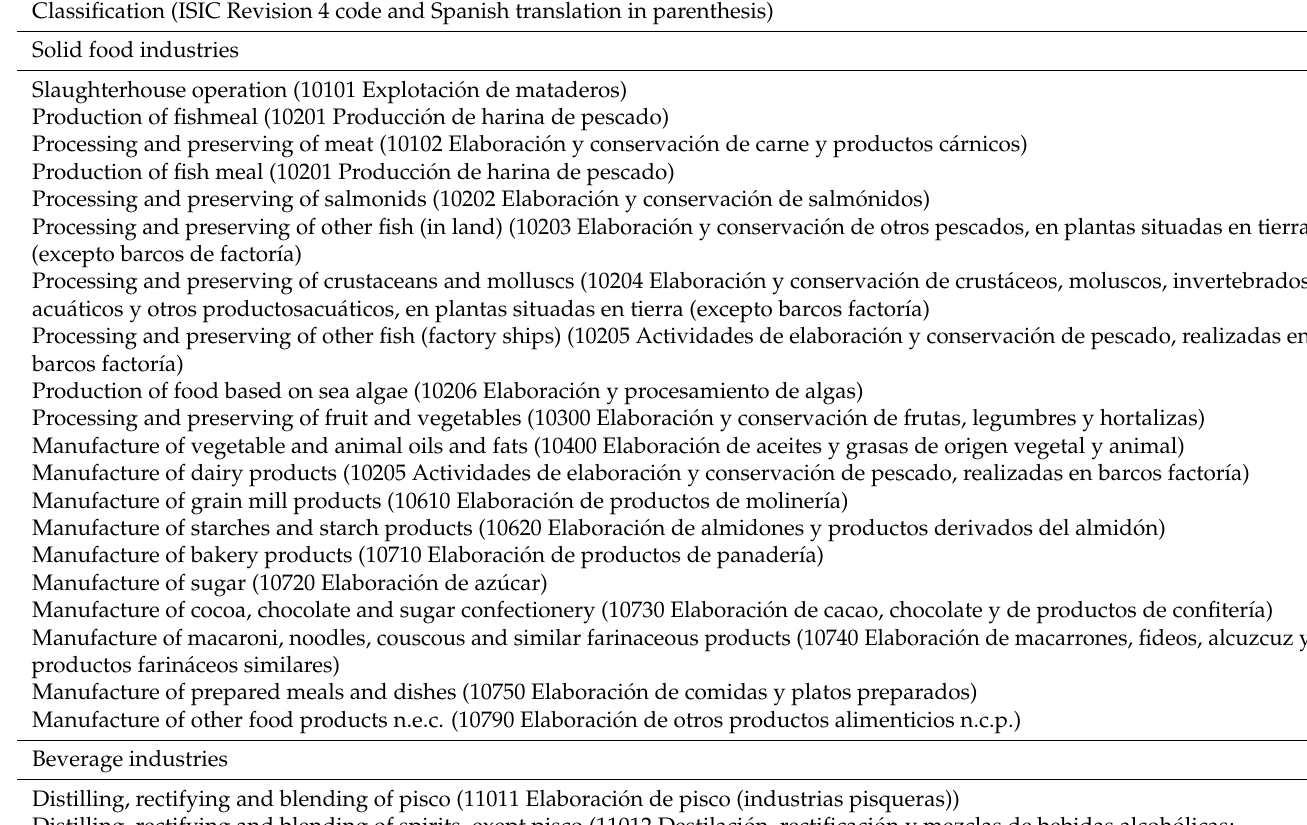
Table A2. Classification of food and beverage manufacturing industries.